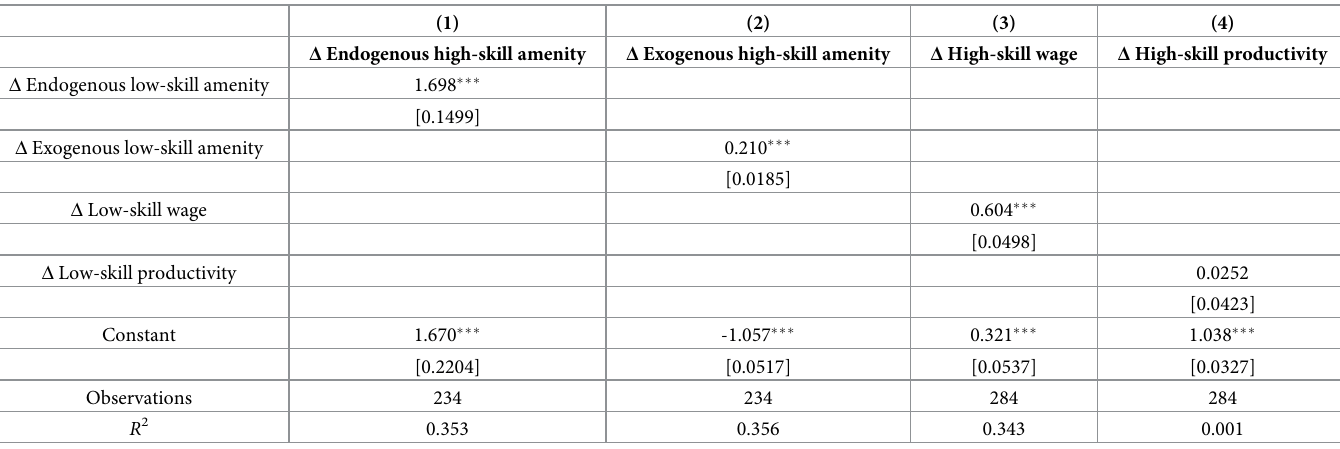
Table 7. The relationship between amenity and productivity